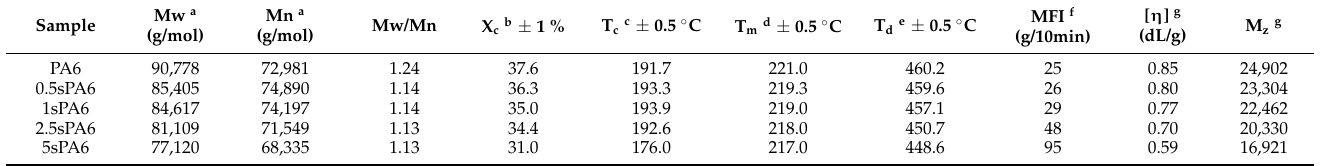
Table 1. Molecular weights, thermal and rheological properties of the star-branched polyamides.